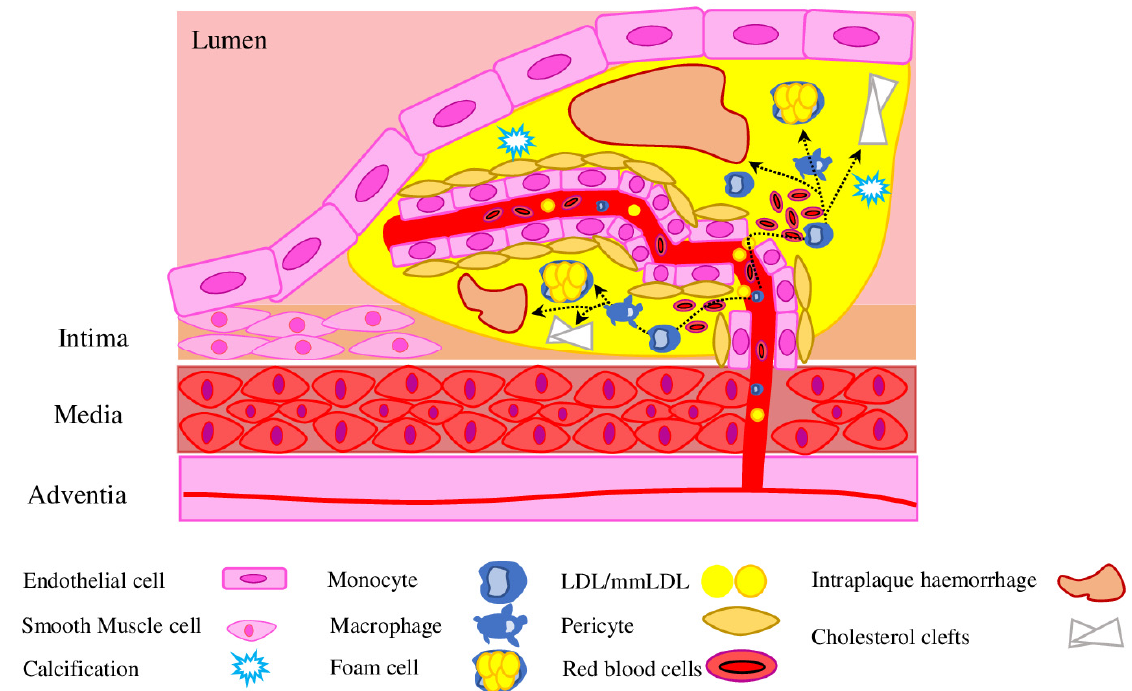
Figure 2. Pericytes in plaque angiogenesis. Plaque neovessels grow predominantly from vasa vasorum under the influence of hypoxia and a VEGF gradient. To become a mature functional vessel, the vessel has to be covered by pericytes. Poor pericyte coverage causes formation of immature leaky neovessels, which allow circulating cells to enter surrounding areas and form an intraplaque haemorrhage, enhance inflammation, calcification and cholesterol deposition.